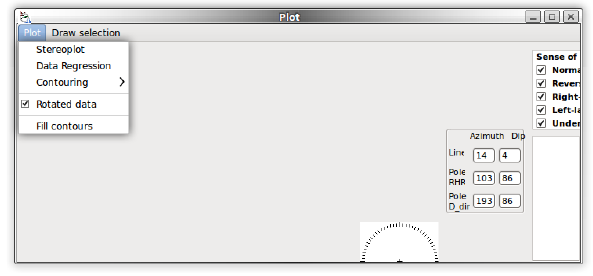
Fig. 6. How to use the rotation function to later project data in their unfolded attitude.